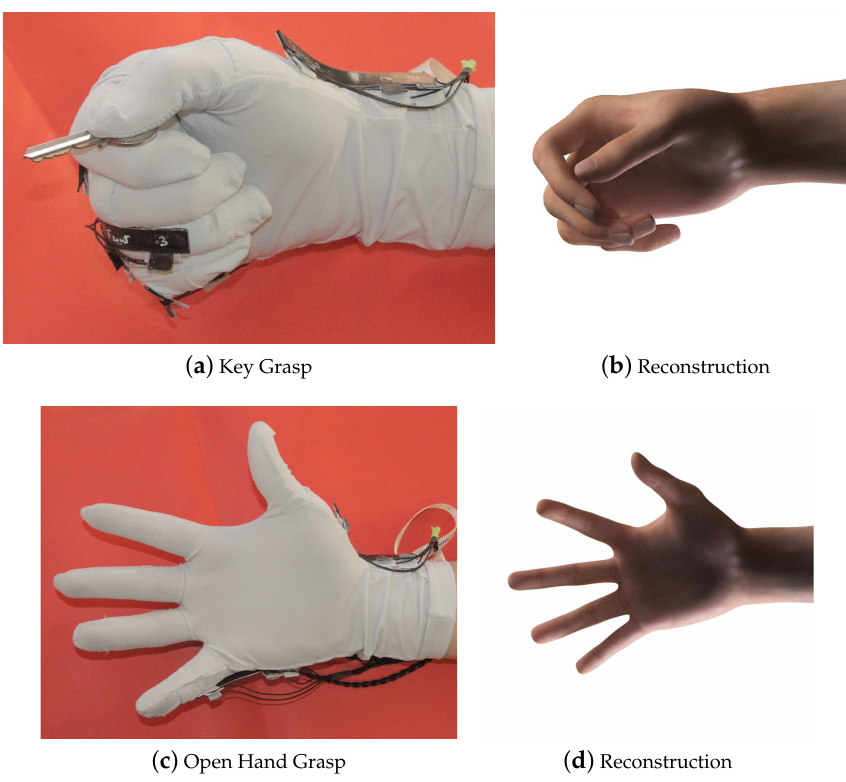
Figure 9. Comparison between real and reconstructed grasps (obtained from the five measurements extended to the 19-DOF pose and rendered in 3D Studio